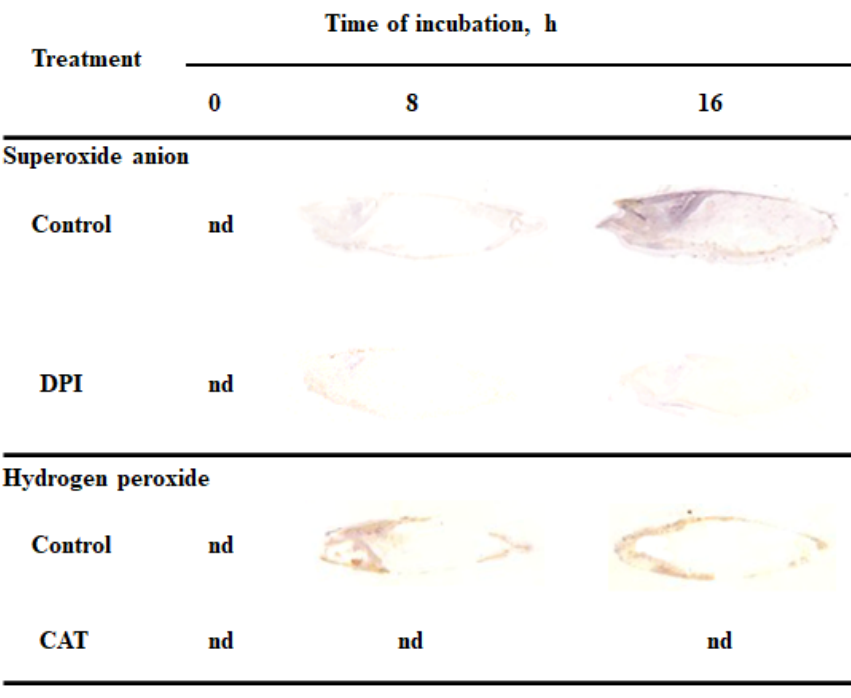
Figure 1. Detection and localization of O 2 •− and H 2 O 2 in Avena fatua seeds incubated in water, diphenyleneiodonium (DPI) (10 − 4 M) or catalase (CAT) (1000 U) at 20 °C for different time by NBT ‐ or DAB ‐ mediated tissue printing of seeds (representative tissue printing are shown). Nd ‐ non detected.